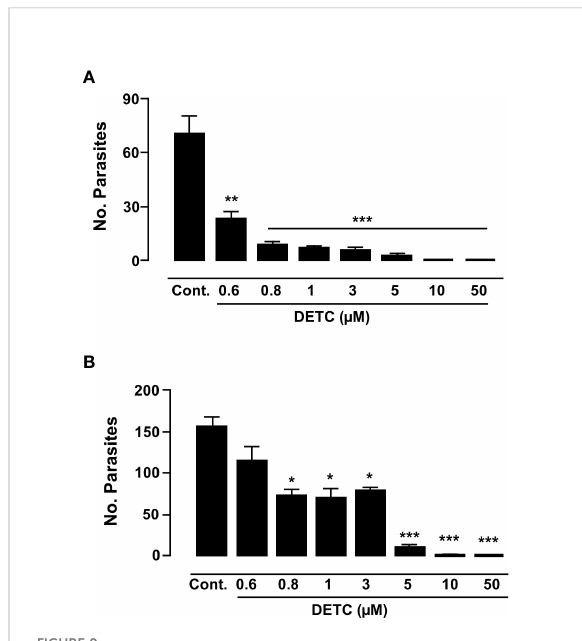
FIGURE 9 Inhibitory effect ofDETConthe proliferation of T.cruzi amastigote forms in Y (A) and Colombiana (B) strains, after incubations of120 h and24h,respectively.* p <0.05,** p <0.01and***indicates p <0.001 ANOVAandDunn ’